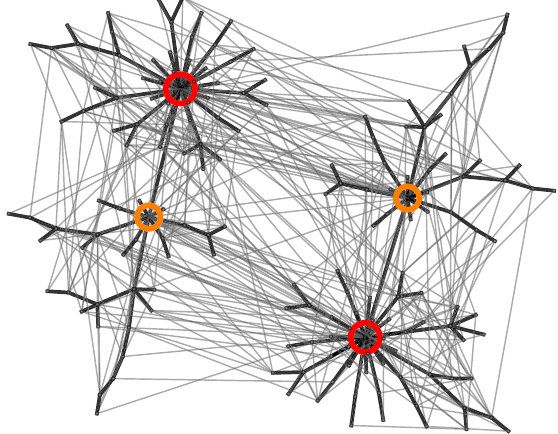
FIG. 2. Undirected kinetic network of the energy landscape of the weakly disordered square-lattice ensemble illustrated in Fig. 1(a). Each grey segment represents an elementary transition between two local minima through a first-order saddle point. The barrier heights and the lengths of the minimum energy paths connecting the minima are disregarded at this stage. The two degenerate ground states are indicated by red circles. Additional hubs ( ρ c ¼ 0 . 33 ) of the kinetic network are indicated by orange circles. The thick black segments highlight the transitions that, starting from a given minimum, lead to a minimum having a lower or equal energy involving the smallest energy barrier [95].